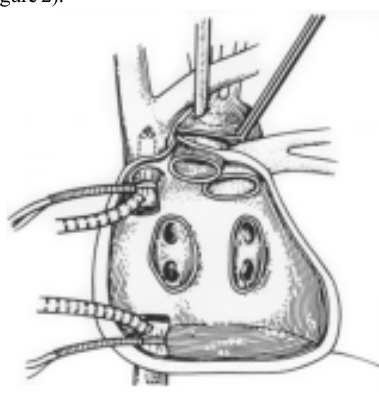
Fig. 2 – Recipient’s organ removed with preservation of the right and left pulmonary veins respectively [9].